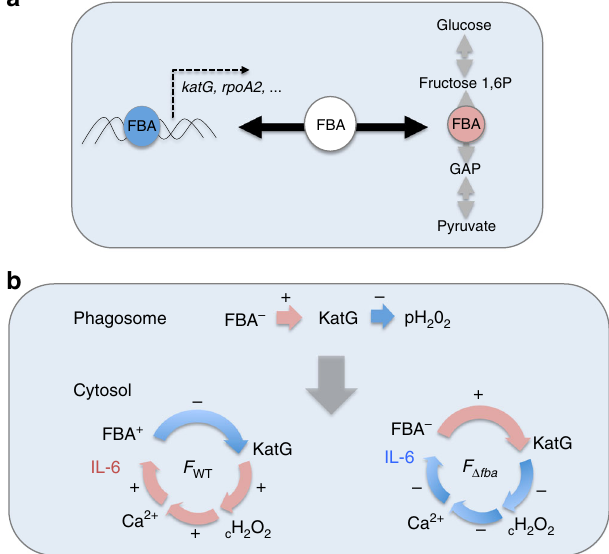
Fig. 8 Proposed model of FBA regulation. a Schematic depiction of the dual role played by FBA: as a fructose biphosphate aldolase in glucose metabolism ( right ); and as transcription regulator ( left ). b Proposed fba - dependent regulation of katG . In the phagosomal compartment ( upper part), fba is not expressed (FBA − ), and katG expression is up-regulated (+) by H 2 O 2 generated by phagosomal NADPH oxidase (pH 2 O 2 ). In the cytosol ( lower part), with the wild-type strain, fba expression is up-regulated (FBA + ), which leads to katG down-regulation ( − ). Cytosolic H 2 O 2 (cH 2 O 2 ) then progressively accumulates which activates the Ca 2+ transporter TRPM2. Increased intracellular Ca 2+ ultimately activates in fl ammatory reactions and notably the production of IL-6. In contrast, with the Δ fba mutant (FBA − ), katG expression is not repressed and cytosolic H 2 O 2 is low. Consequently, the TRPM2-dependent Ca 2+ accumulation is limited and IL-6